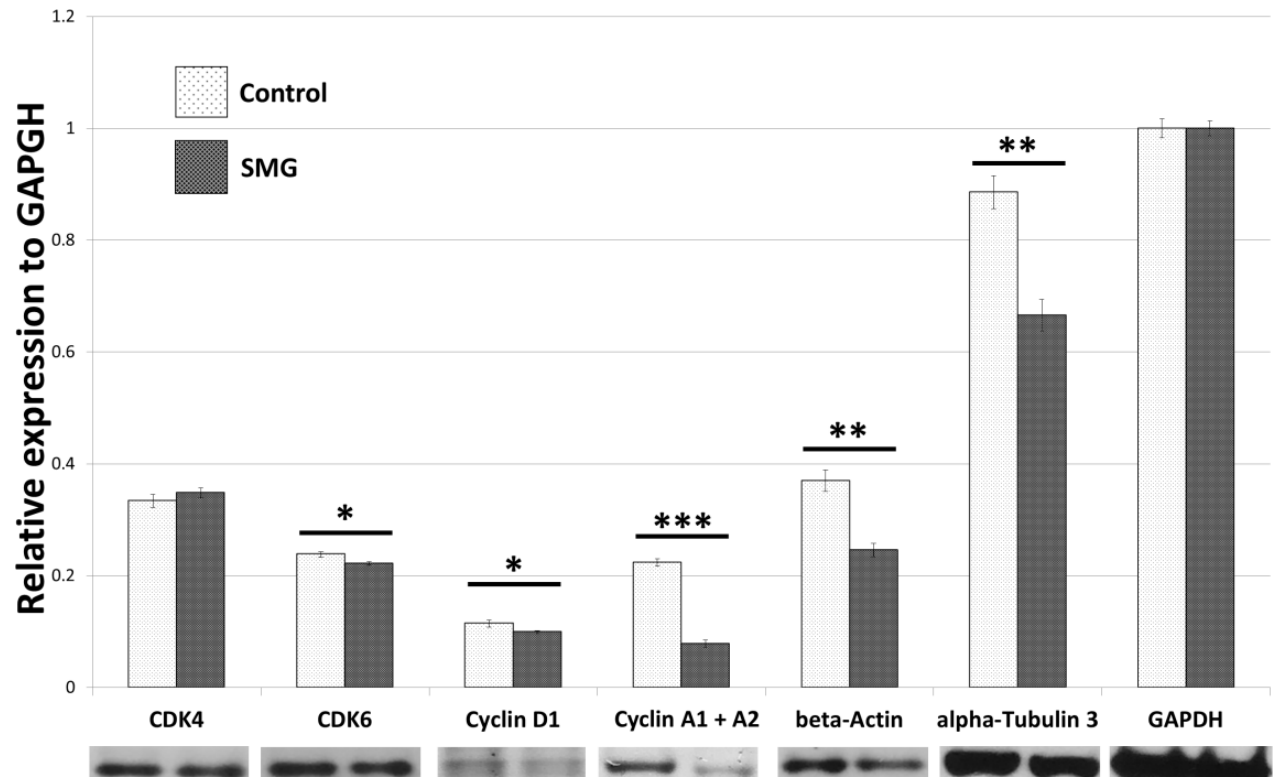
Figure 2. Western blot analysis of major cell cycle regulators and main cytoskeletal proteins in CCL-13 cells ( n = 3). *** indicates significant difference compared with the control group ( p < 0.001); ** indicates significant difference compared with the control group ( p < 0.01); * indicates significant difference compared with the control group ( p < 0.05).